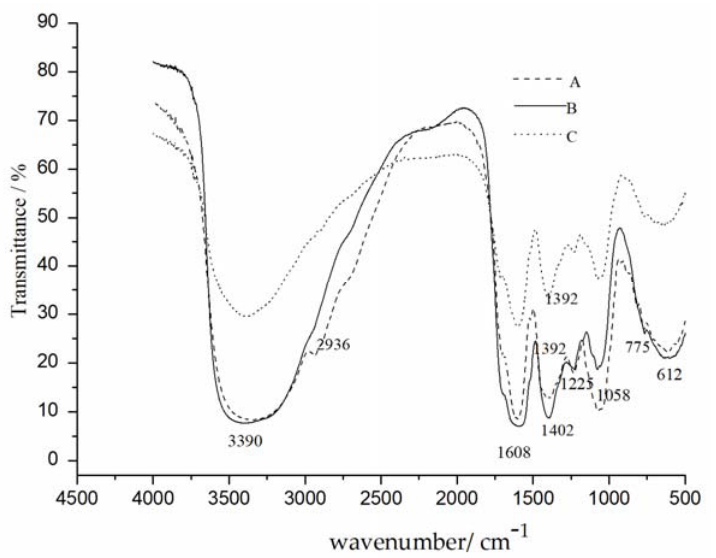
Figure 9. Infrared analysis results of crude polysaccharides (A), CALP-1 (B), and CALP-2 (C).